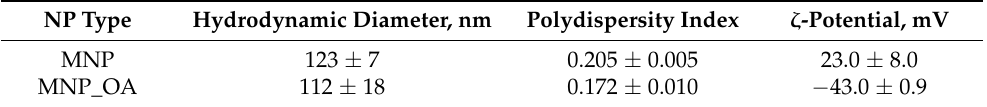
Table 1. DLS data for MNP and MNP_OA.